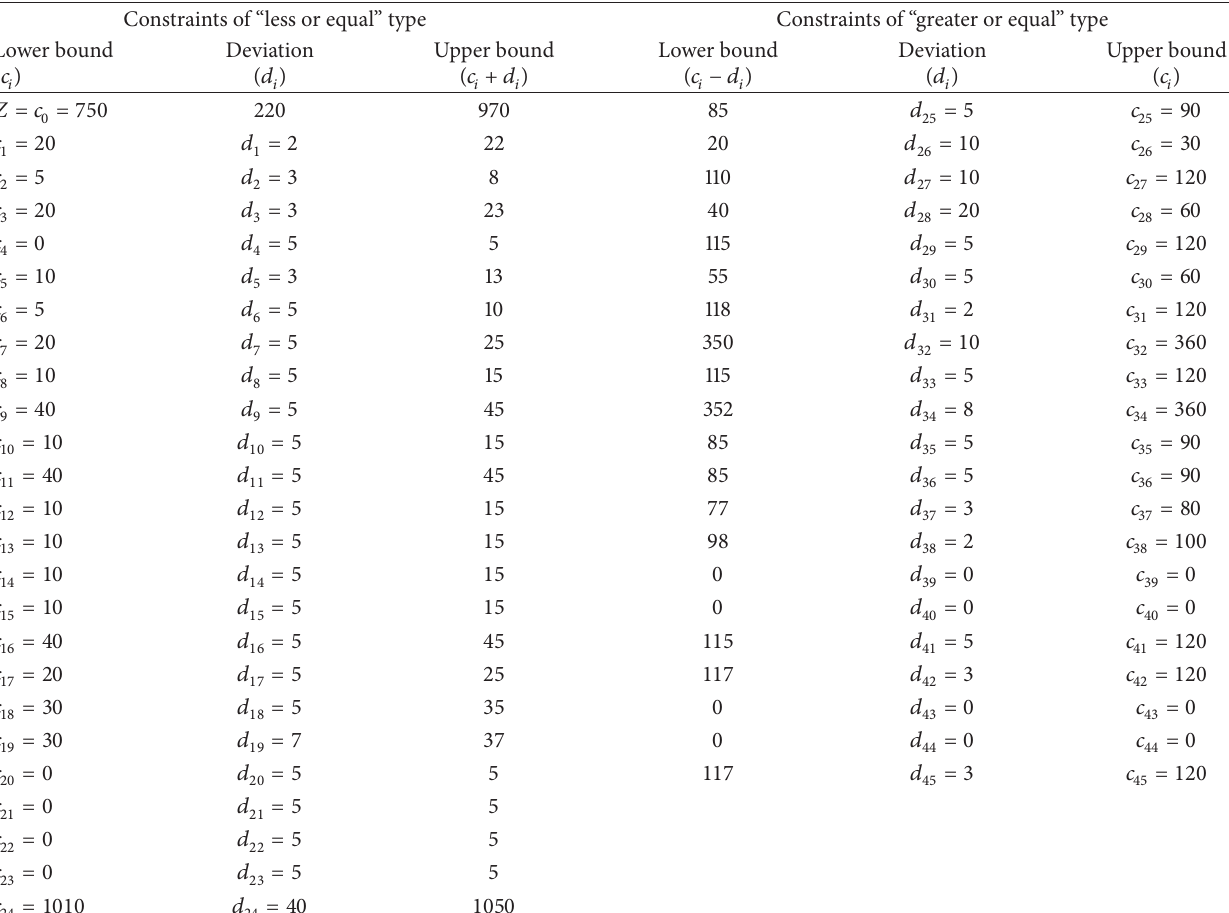
Table 2: Permissible tolerances for project time-cost tradeoff